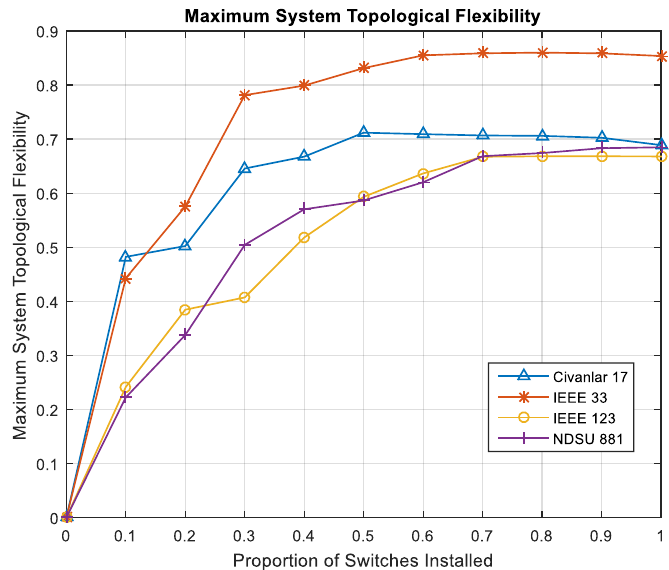
Figure 11. Maximum system topological flexibility of different distribution networks.